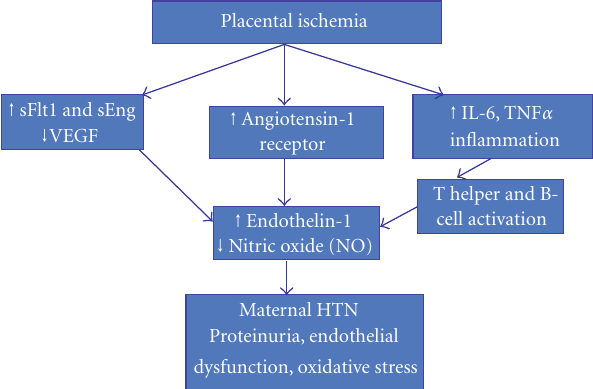
Figure 1: Showing unified hypothesis on pathogenesis of endothe- lial dysfunction, hypertension, and edema with